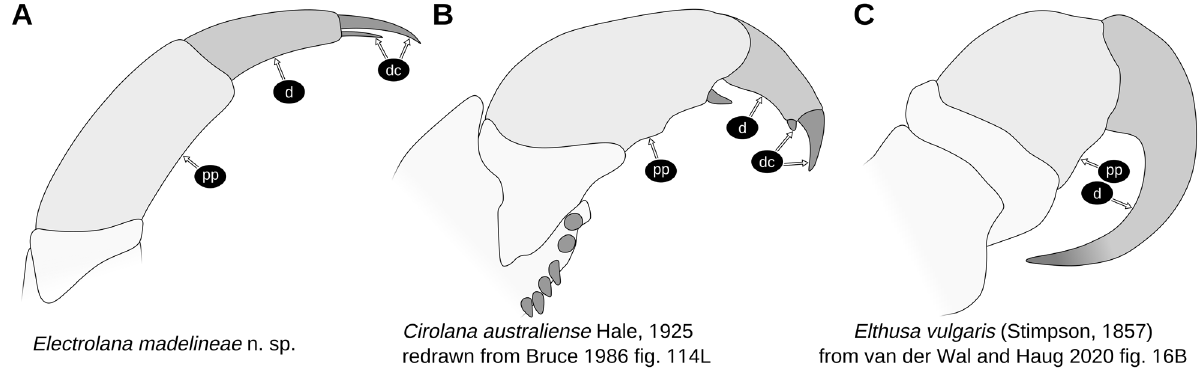
Figure 8. Comparison of the distal part of trunk appendage 1 in different lineages of Cymothoida. A : Electrolana madelineae n. sp., schematic reconstruction; B : Cirolana australiense Hale, 1925, redrawn from Bruce (1986, fig. 114L); C : Elthusa vulgaris (Stimpson, 1857), drawn after van der Wal and Haug (2020, fig. 16B). d, dactylus, dc, claws of dactylus, pp,